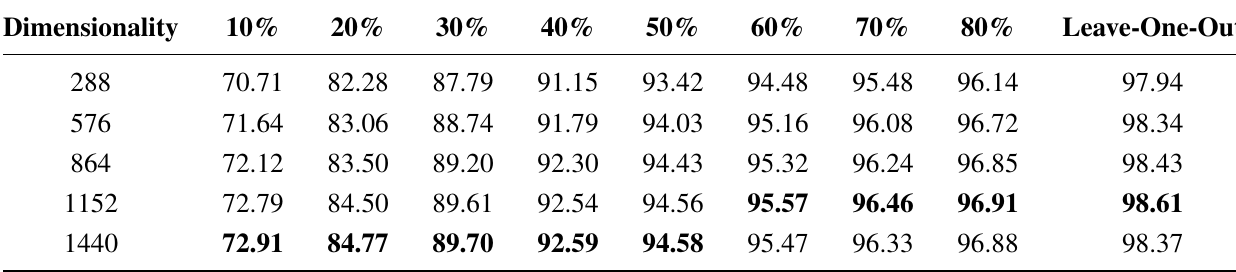
Table 7. Accuracy of infrared ATR (%) for sSCC_OC_RLTP by FSDE [47] under different training